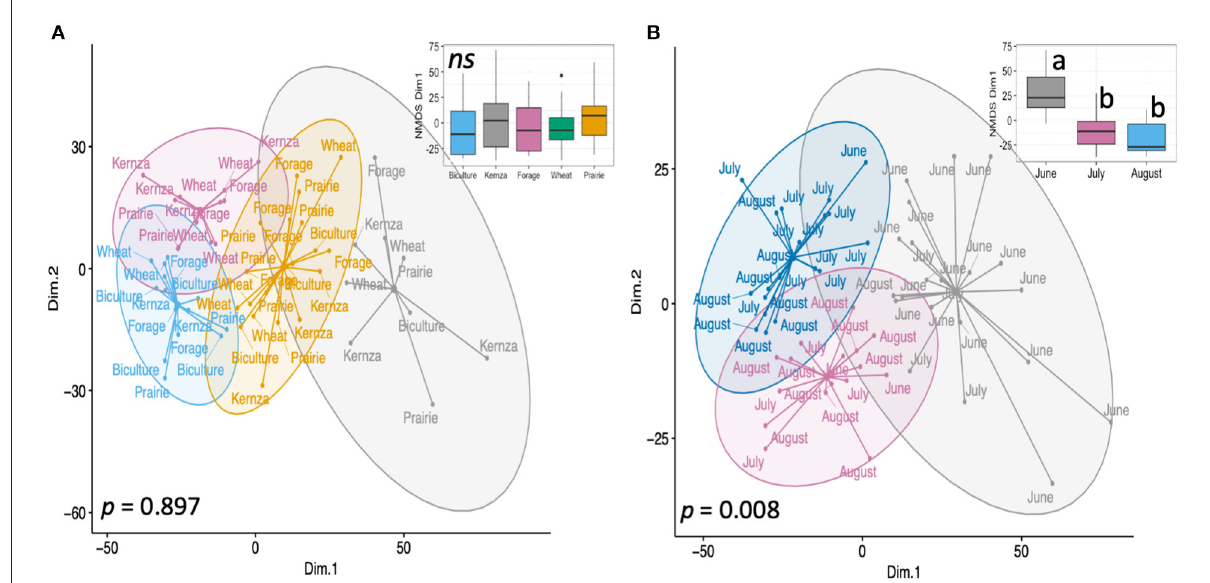
FIGURE4 Non-metric Multidimensional Scaling (NMDS) ordination of soil properties with fitted k -means cluster ellipses to illustrate relationships between (A) crop treatment, and (B) sampling month. p- value by PERMANOVA.